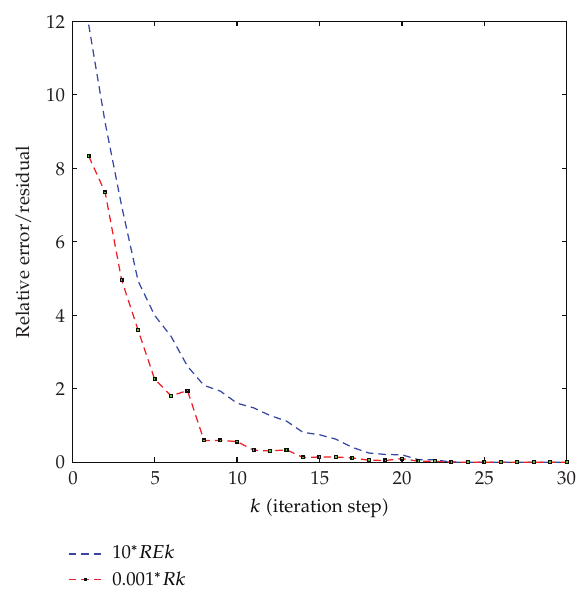
Figure 4: The relative error of the solutions and the residual for Example